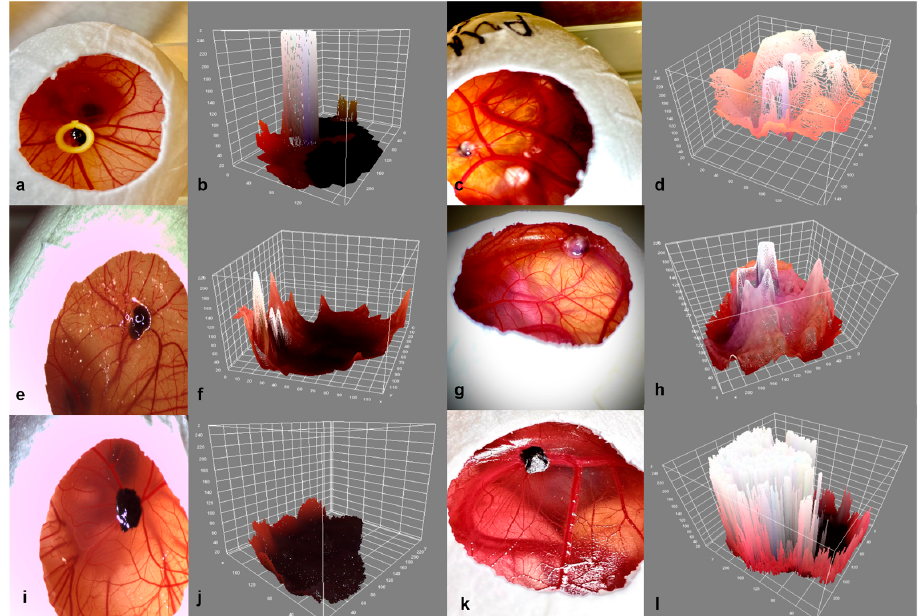
Figure 11. Three-dimensional visualization of the tumors on ED7 and ED18 in the three experi- mental groups. ( a – d ) Graft + Matrigel + ring, ( e – h ) graft + Matrigel, ( i – l ) graft alone, ( b , f , j ) 3-D re- construction of the implanted tumor grafts on ED7 for groups 1, 2, and 3, ( d , h , l ) 3-D reconstruction of the implanted tumor grafts on ED18 for groups 1, 2, and 3 using the three-dimensional surface plot plug-in in Image